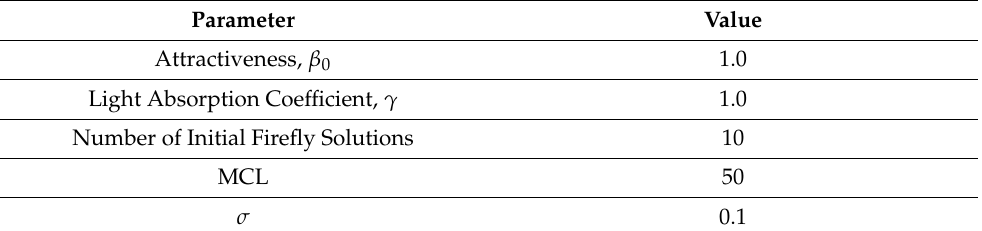
Table 4. Parameter settings of the FA.